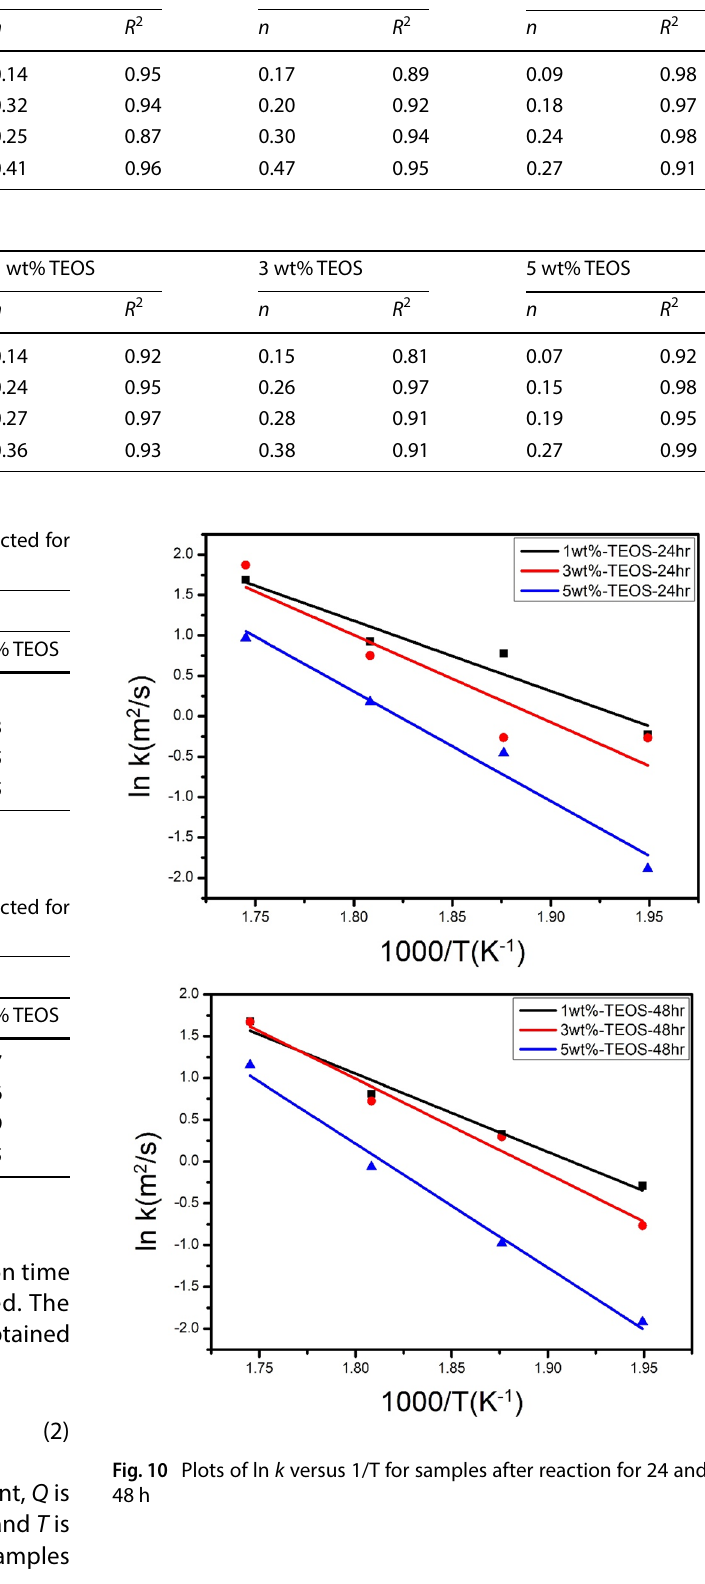
Table 3 Time exponent ( n ) and the goodness-of-fit ( R 2 ) for samples coated with TEOS and reacted for 24 h after soldering at various temperatures